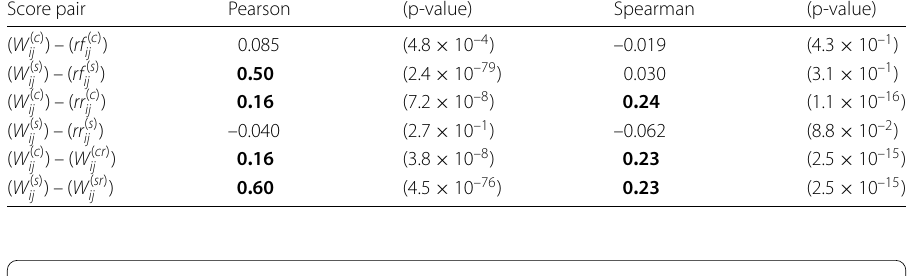
Table 2 The correlations between the scores from sales data, ( W ( c ) the flavour compound and recipe data, ( rf ij ), ( rr ij ) (where the superscripts ( c ) and ( s ) below denote the values restricted to { ( i , j ) : W ( c ) Score pair Pearson